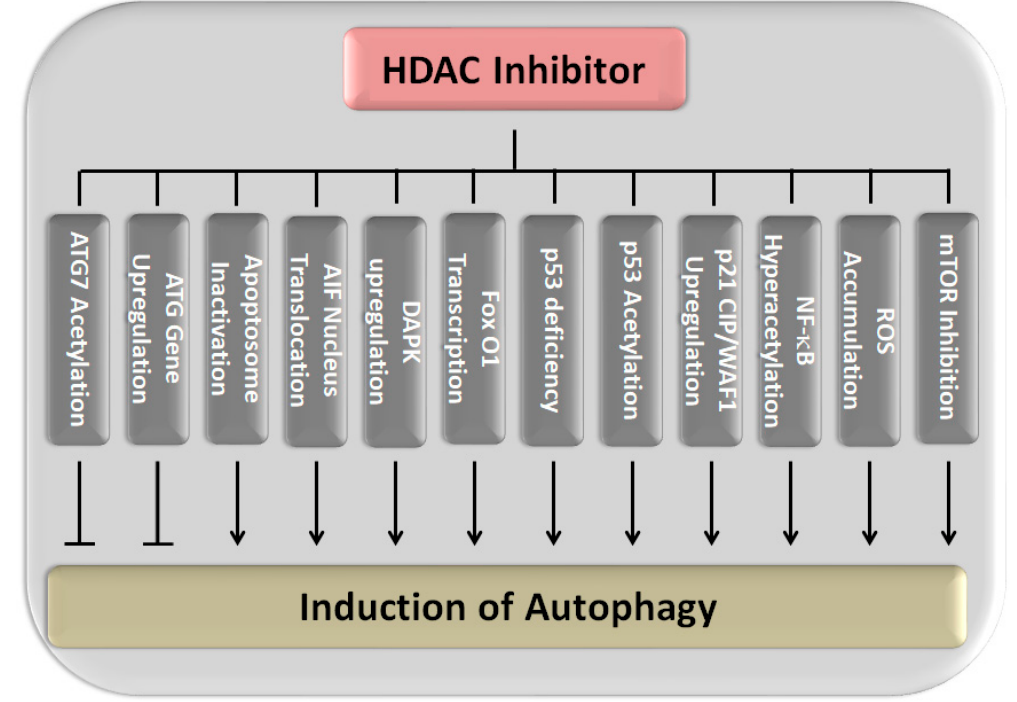
Figure 1. Known signaling pathways involved in histone deacetylase inhibitor-elicited activation or suppression of autophagy. In most cases mTOR inhibition, ROS accumulation, NF- κ B hyperacetylation, p21 upregulation, or the involvement of p53 signaling is observed.